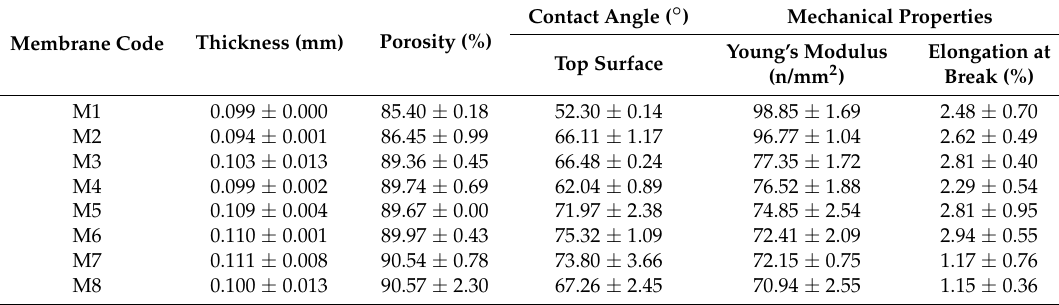
Table 4. Thickness, porosity, contact angle and mechanical properties of the prepared PES and PES–kaolin